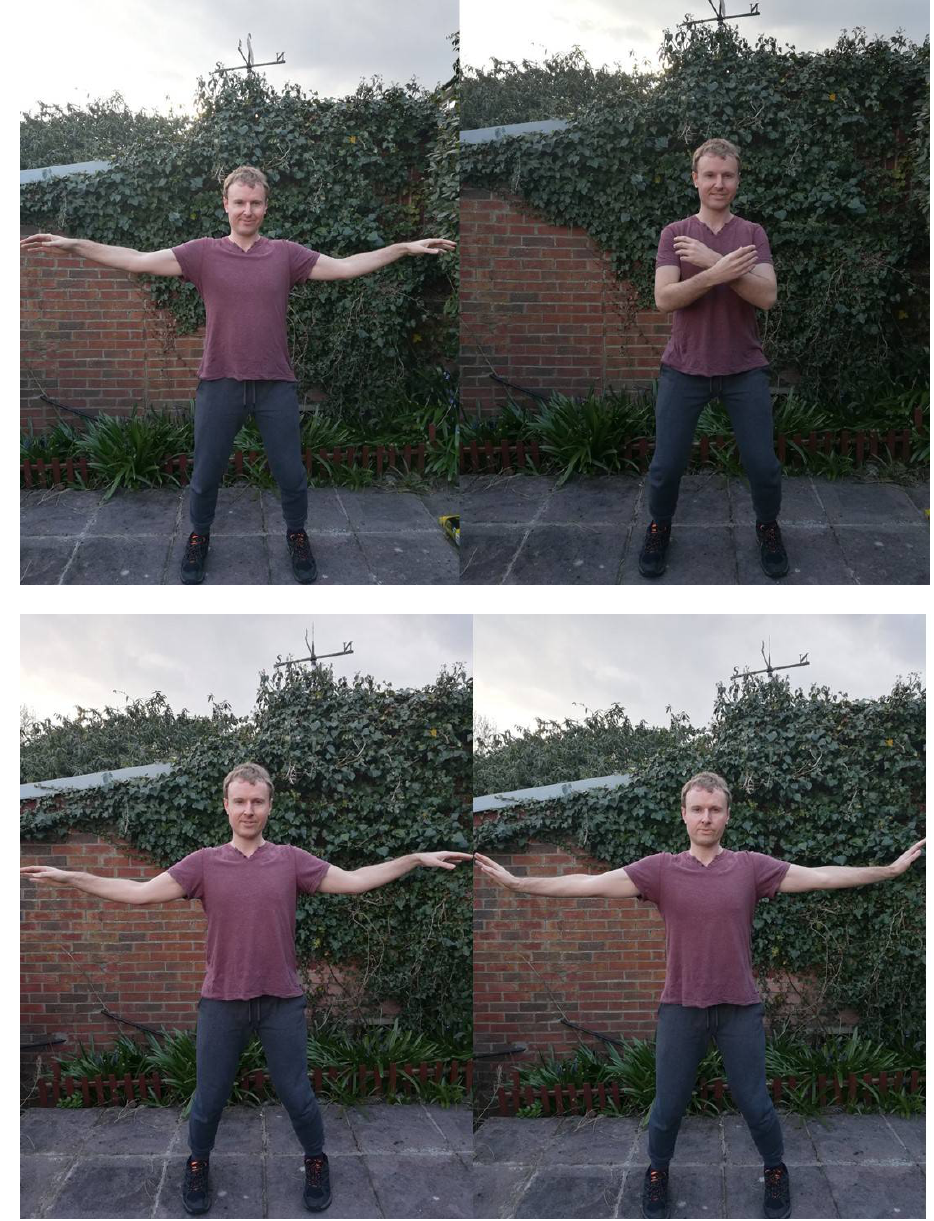
Figure 2. Shoulder Loosening Exercises and the Palm Stretch.